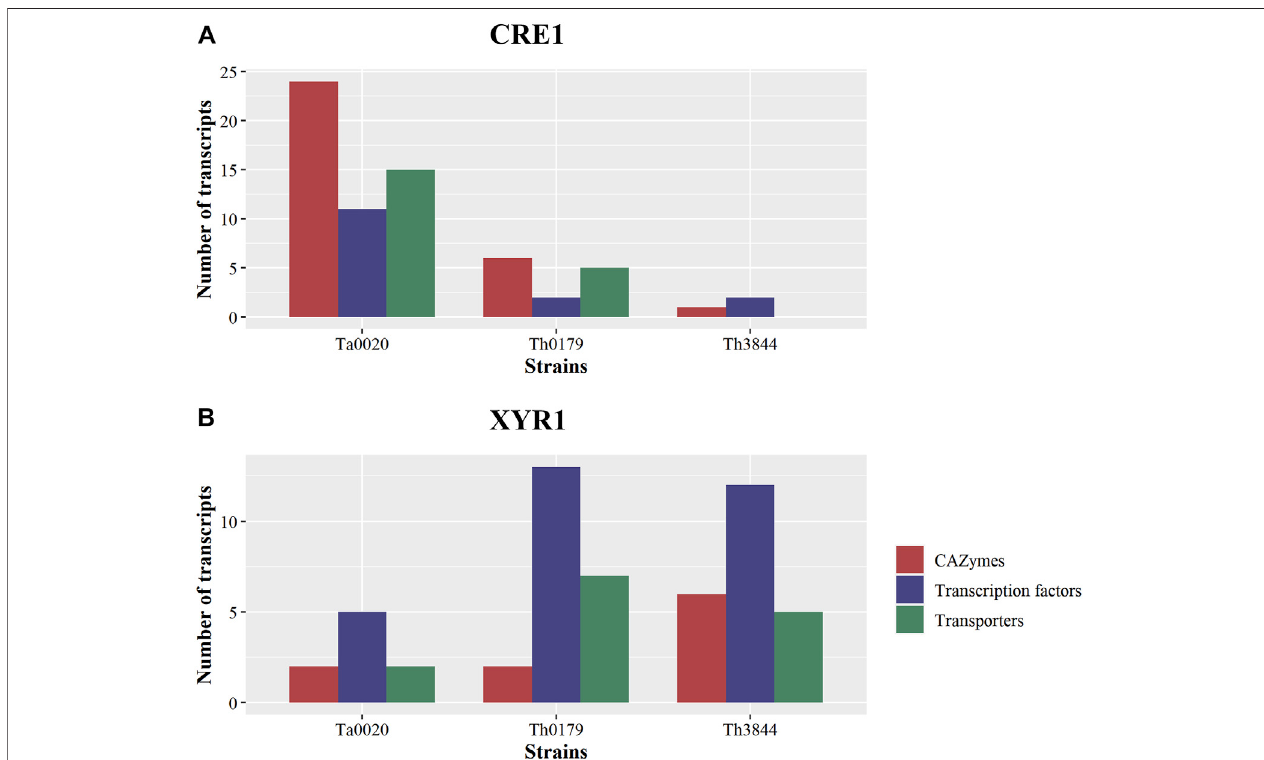
FIGURE 3 | Comparisons of TFs, transporters, and CAZymes among strains and groups. Number of transcripts encoding TFs, transporters, and CAZymes in Ta0020, Th0179, and Th3844 distributed among the cre1 (A) and xyr1 (B) groups. The number of transcripts encoding these proteins associated with cre1 was more accentuatedinTa0020thanthoseobservedfortheotherstrains,whileinthe xyr1 group,both T.harzianum strainspresentedagreatnumberofcoexpressedtranscripts encoding TFs, followed by those encoding transporters. Th3844 also showed a high number of CAZymes in the xyr1 group. TFs: transcription factors; CAZymes: carbohydrate-active enzymes. Ta0020: T. atroviride CBMAI-0020; Th0179: T. harzianum CBMAI-0179; Th3844: T. harzianum IOC-3844.